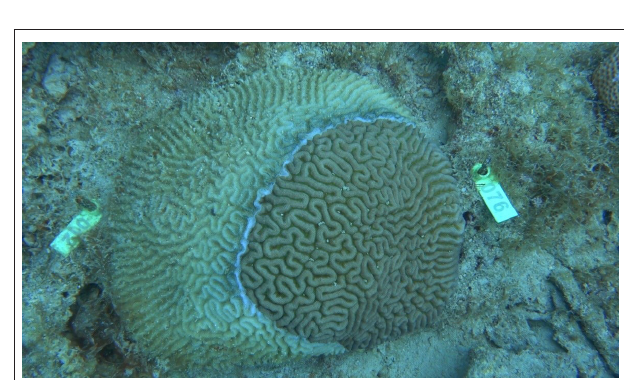
FIGURE 3 | Monitored coral. Example alignment of unique numbered cattle-tags for monitoring of a P. strigosa affected with SCTLD using 3D